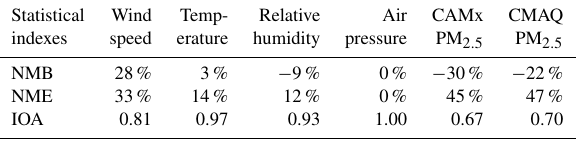
Table 2. Statistics of simulation verification for meteorological pa- rameters and hourly PM 2 . 5 concentration.